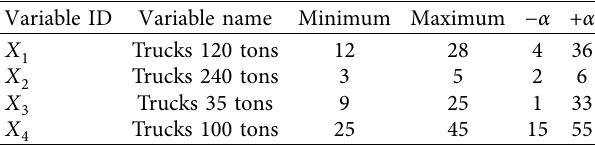
Figure 2: Research solution approach framework. Table 4: Predetermined parameters of experimental